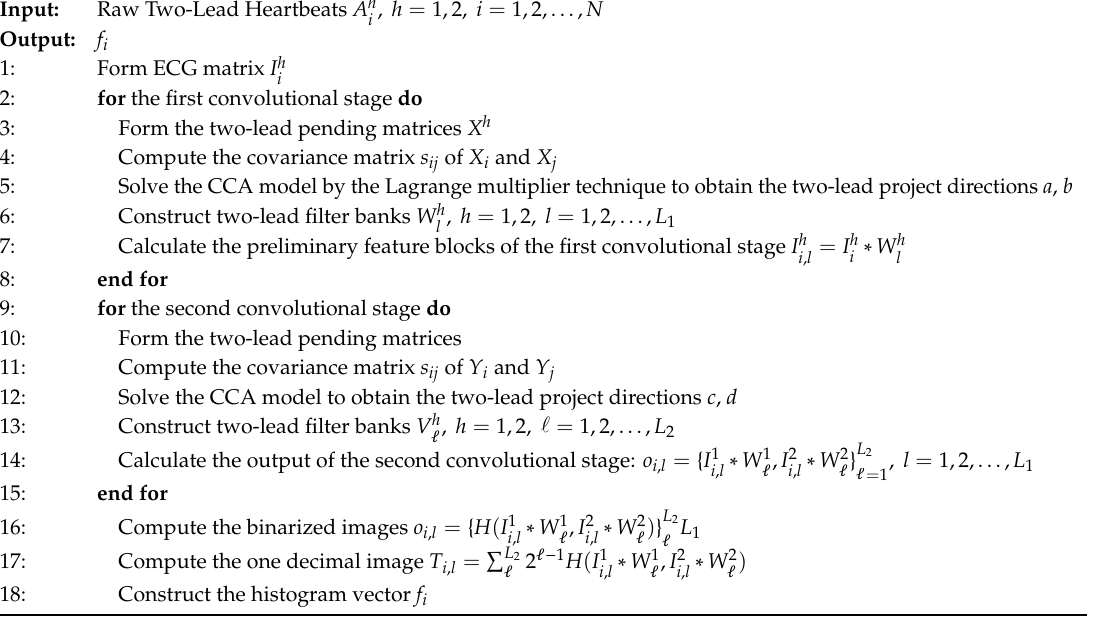
Algorithm 1. The algorithm of two convolutional stages of the DL-CCANet.